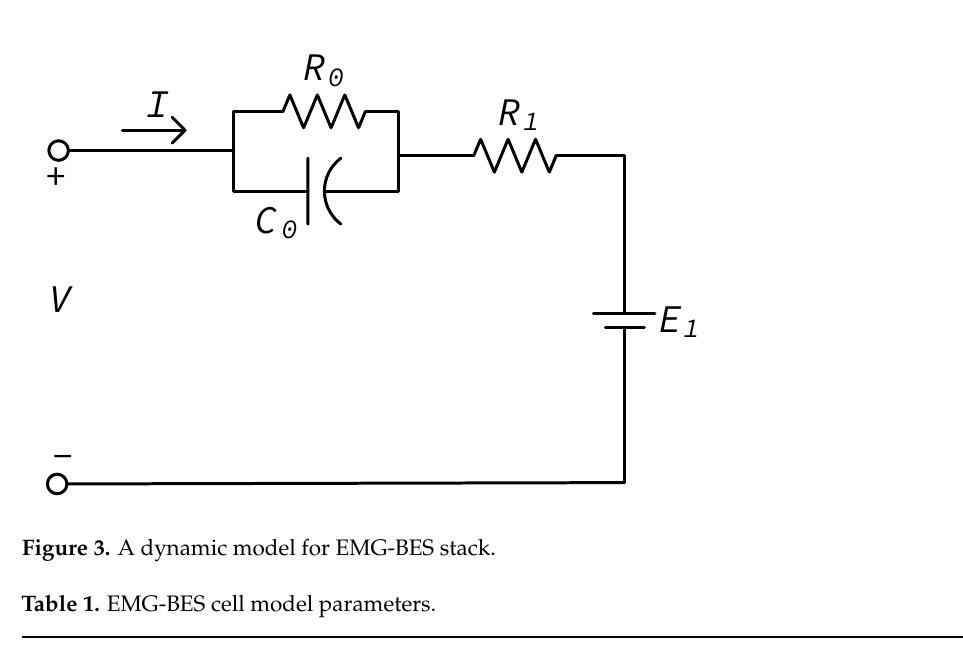
Figure 2. Current vs. voltage for 15 parallel EMG-BES cells.